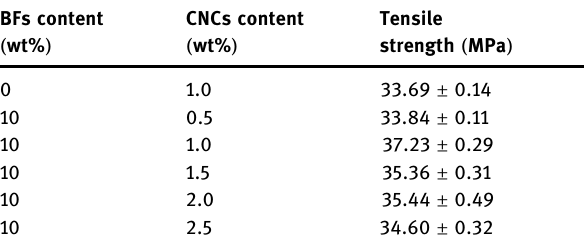
Table 2: Tensile strength of composite samples with di ff erent CNCs